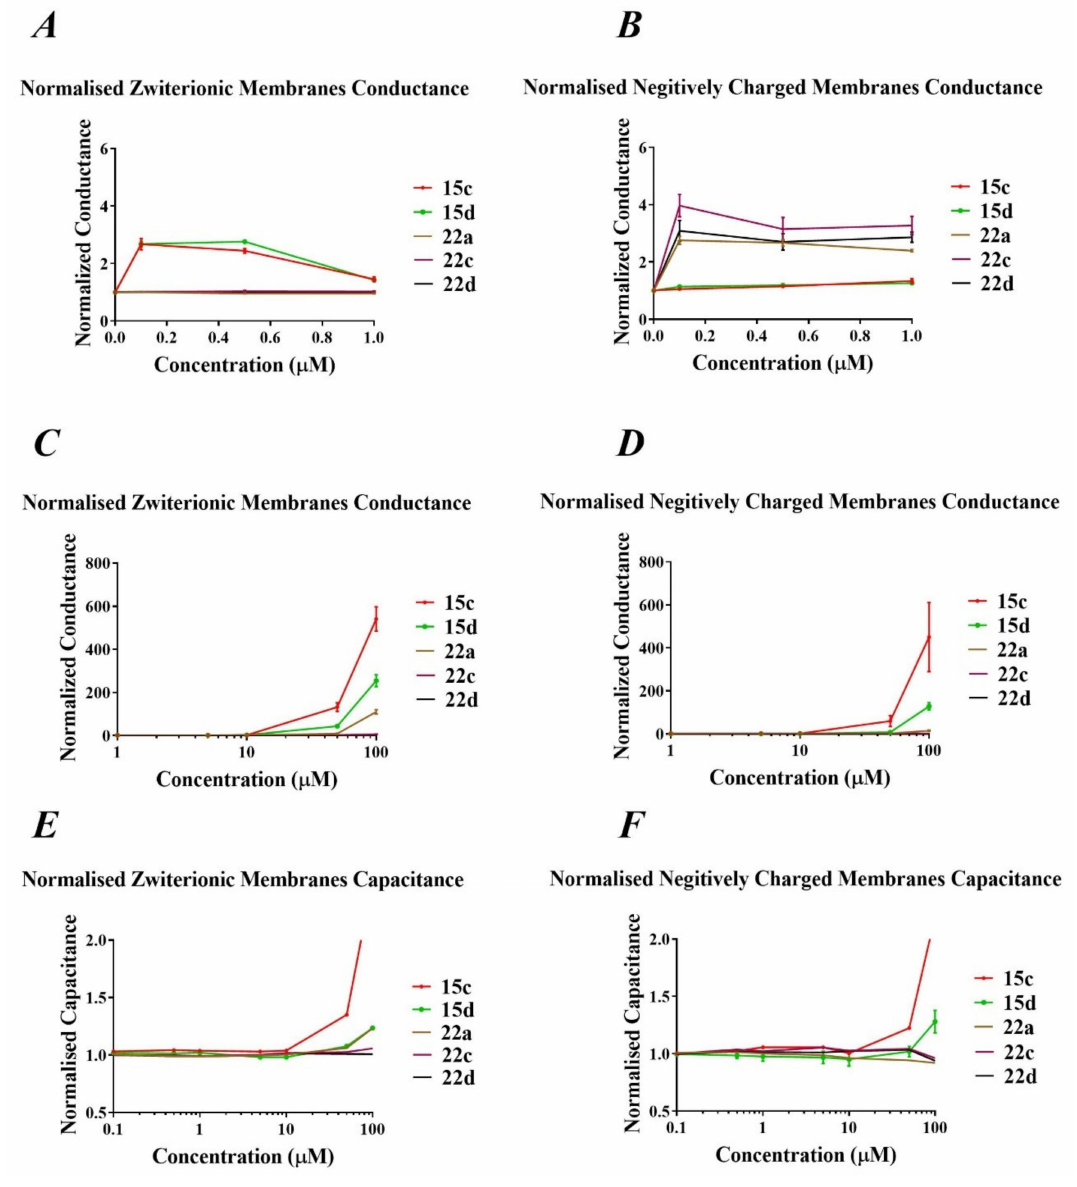
Figure 7. ( A ) Changes in membrane conductance caused by the addition of the compounds at concentrations less than 1 µ M in ( A ) zwitterionic POPC tBLMs, and ( B ) tBLMs containing 30% negatively charged POPG lipids. Large increases in membrane conduction due to select compounds are also visible at higher concentrations (1–100 µ M) in ( C ) zwitterionic POPC tBLMs, and ( D ) tBLMs containing 30% negatively charged POPG lipids. Large increases in membrane capacitance in ( E ) zwitterionic tBLMs, and ( F ) negatively charged tBLMs, suggests that high concentrations of compounds lead to massive disruption of the lipid bilayers. Error bars represent the standard errors from n = 3 replicates for each compound, with the exception of 15c , which is n =